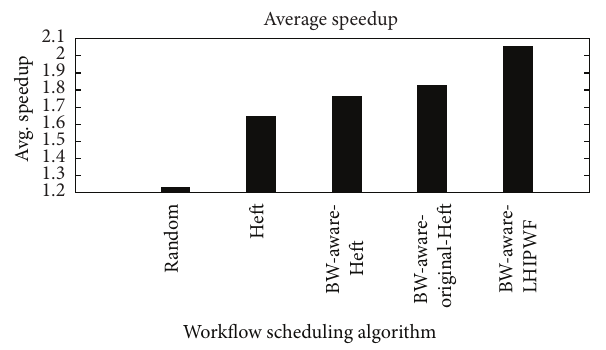
Figure 15: Comparison of Average Speedup of the two workflows of 41 tasks achieved by workflow scheduling